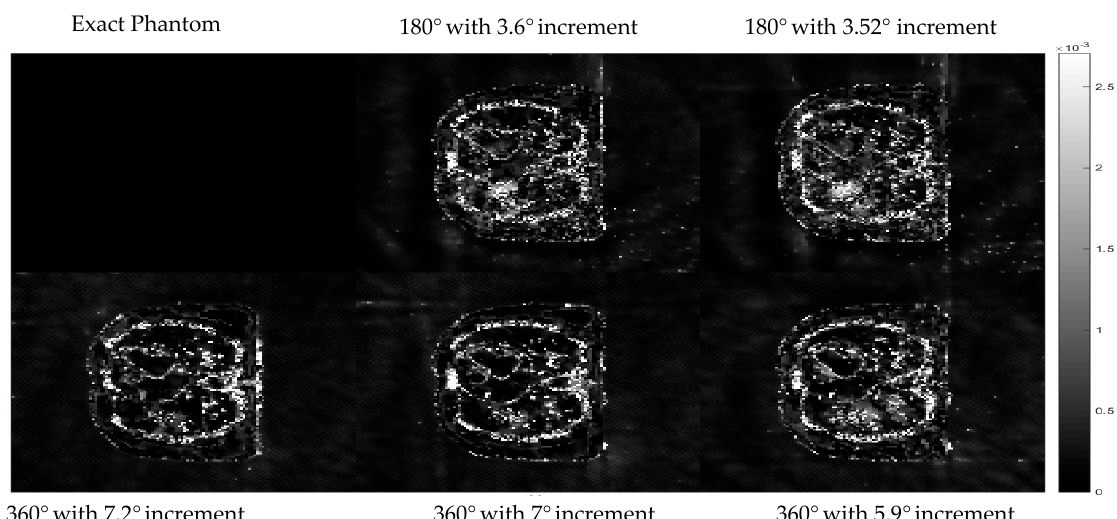
Figure 9. The difference between reconstructed images using proposed methods with reference data using the set of hyperparameters from the proposed algorithm with respect to different angle arrangement. The display window is